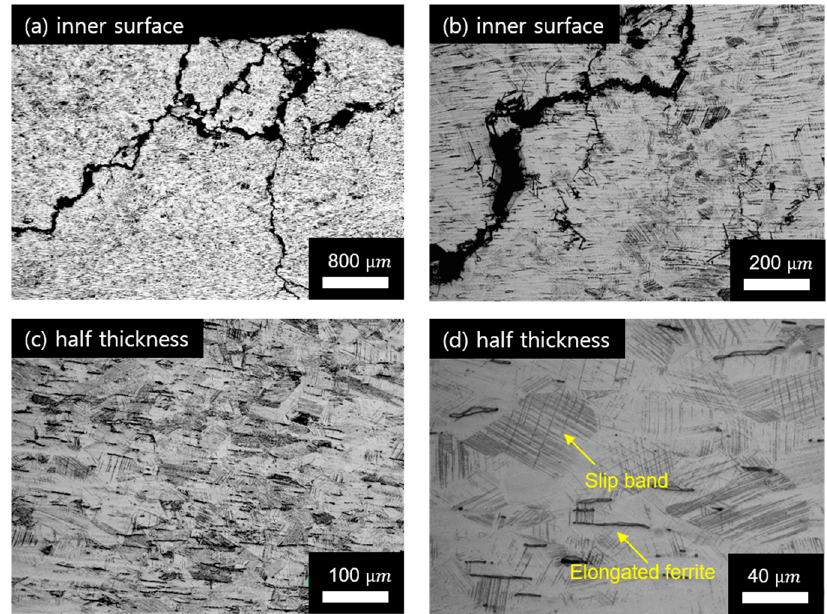
Figure 3. ( a ) The microstructure obtained from bottom part of the AISI 304 reactor, which is cold formed. ( a ) Low magnification of the inner surface region. ( b ) Higher magnification image of the region in ( a ) shows the high density of slip bands within grains and the morphology of the crack is step-wise. ( c ) The microstructure of the half thickness region of the cold formed reactor and ( d ) enlarged image of ( c ), which exhibited a high density of slip bands and elongated ferrite.